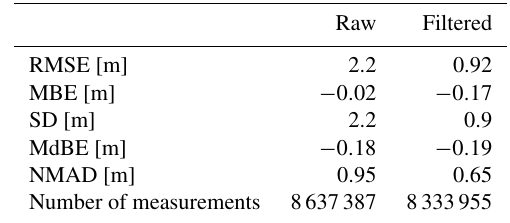
Table 6. Accuracy and precision assessment for comparison 3, where the satellite data are assessed against the airplane data: the column “Raw” contains the results for all the values and the col- umn “Filtered” the results where plus or minus 2 SDs are removed. The filter removed 3.5% of the